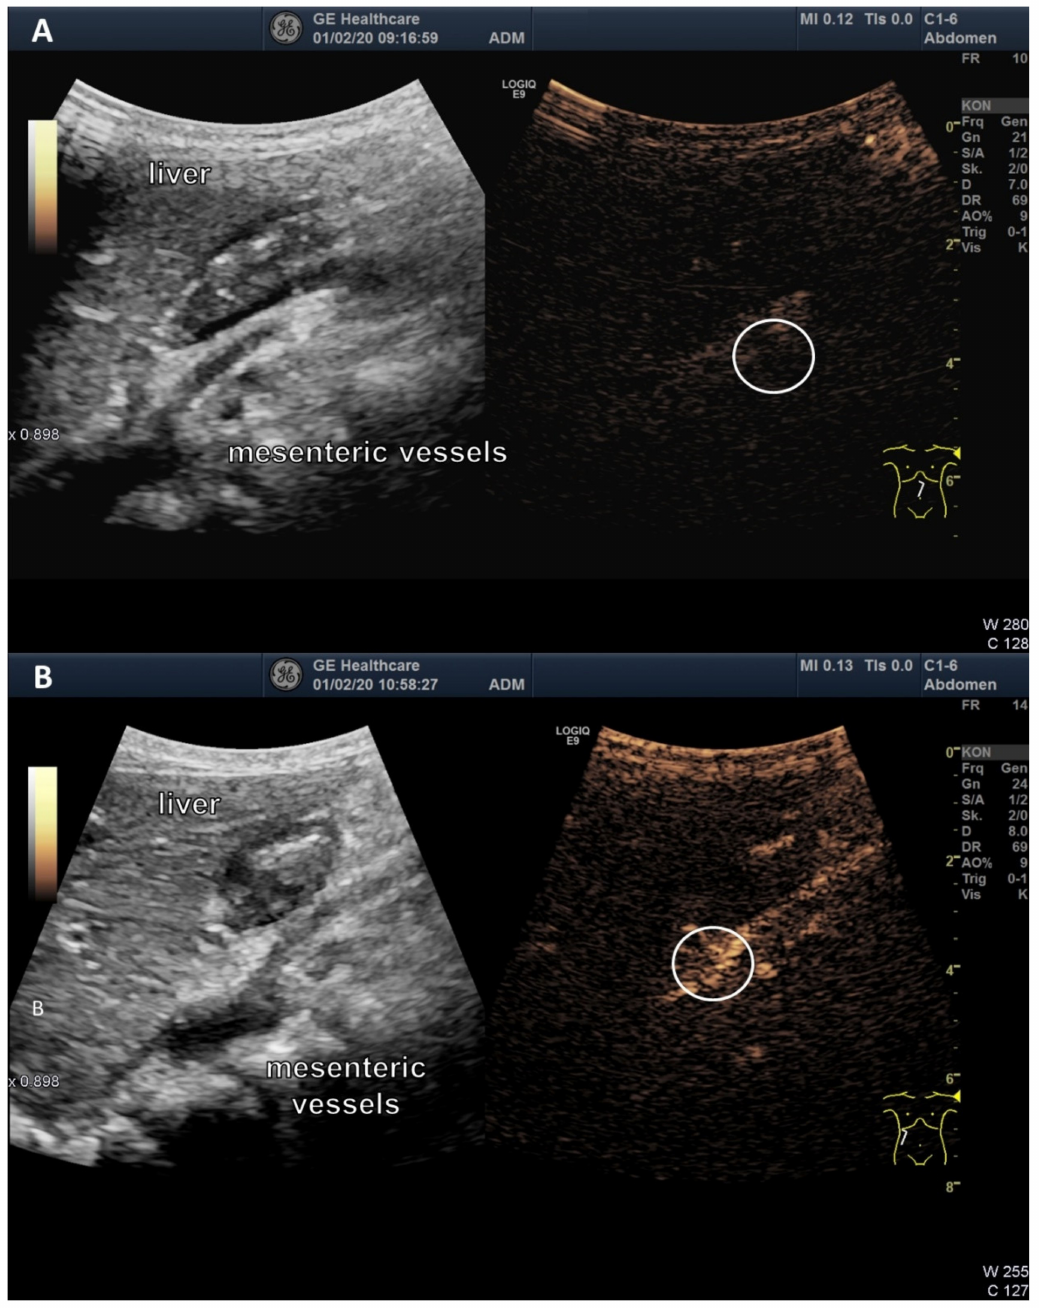
Figure 4. High-resolution ultrasound, multi-frequency C1-6 MHz probe. Abdominal ultrasound images before ( A ) and 90 minutes after oral application of vitamin C formula ( B ) from one volunteer. The circles show the mesenteric vessels. There is a clear microbubble signal indicating the intestinal absorption of